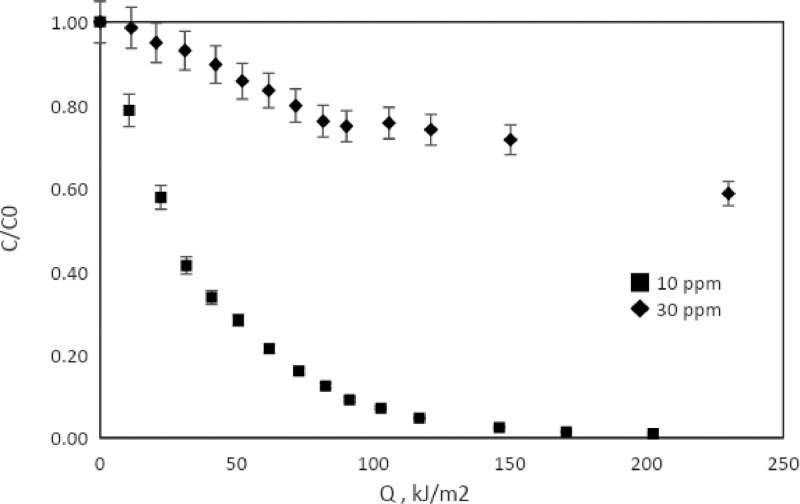
Degradation of AM vs UV energy accumulated. 0.1 g/L of TiO2/Fe3O4 (80/20).